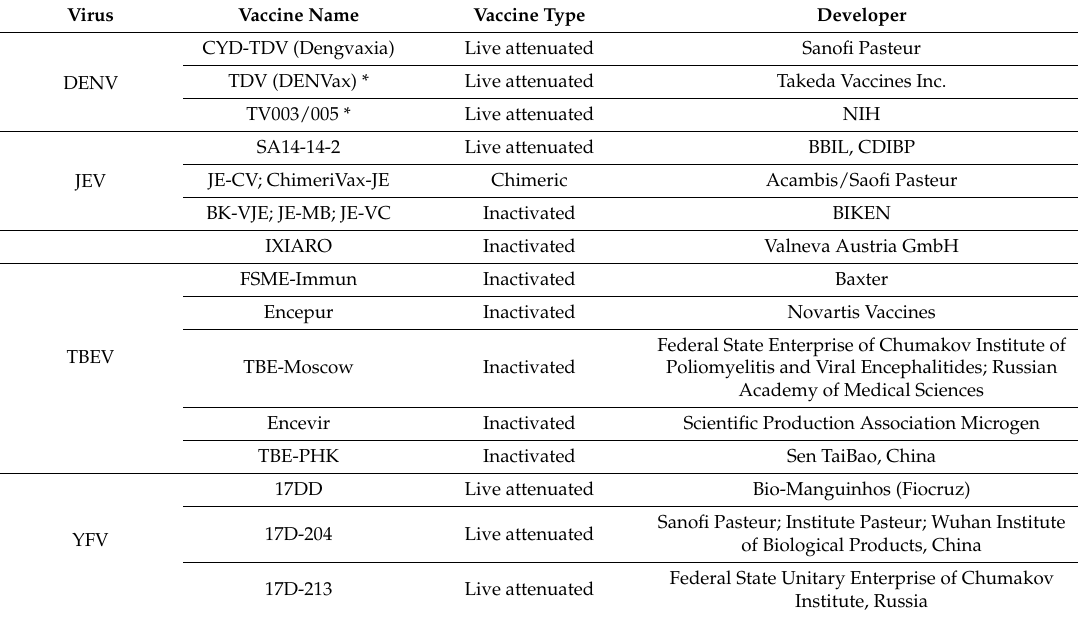
Table 1. Licensed human flavivirus